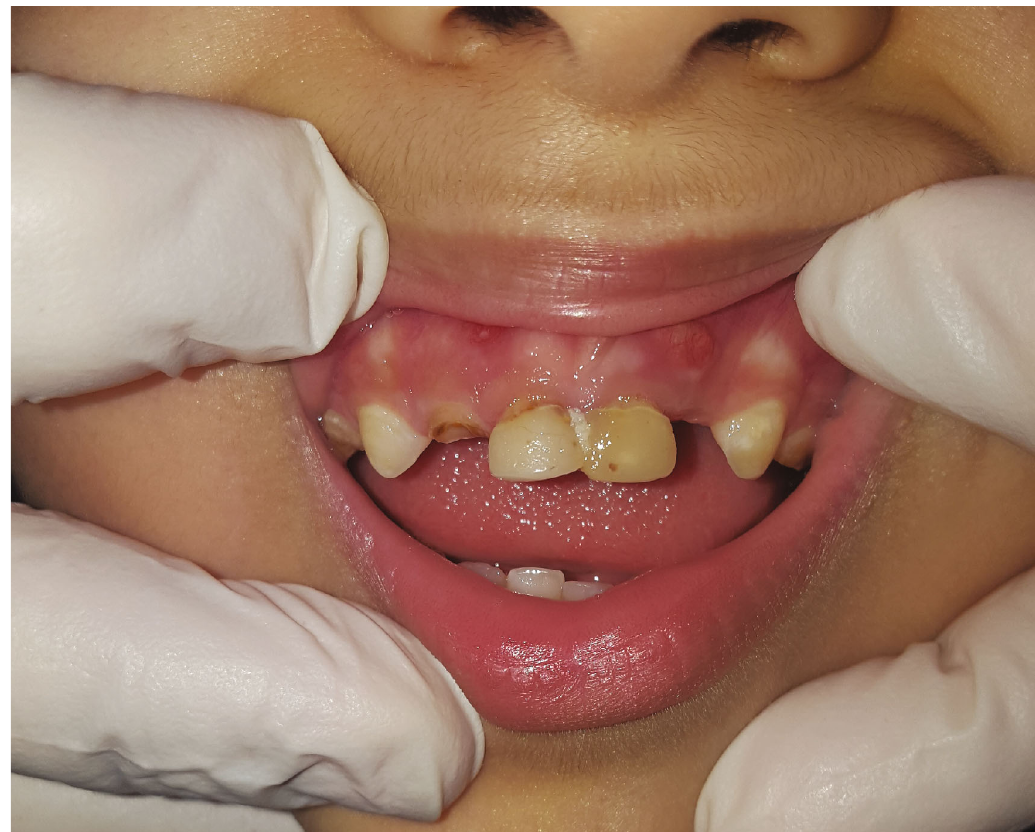
Figure 3: Clinical crowns of central incisors.